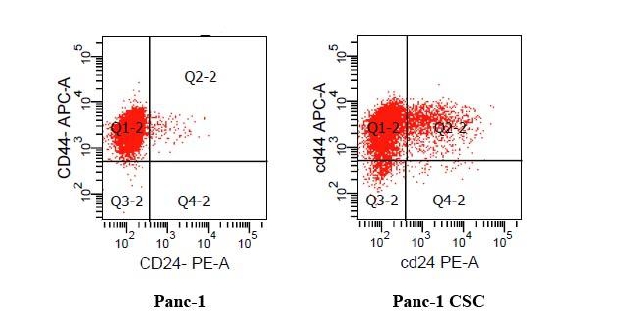
Figure 1 . The Panc-1 cell cancer stem cell (CSC) subpopulation (CD44+/CD24+) was enriched under sphere-forming conditions. The right upper quadrant (Q2-2) indicates the distribution of the CD44+/CD24+ subgroup of cells as analyzed by flow cytometry. The experiment was repeated 5 times and the data are expressed as mean ± standard deviation, statistically significant differences were determined by Student’s t test, the difference between the Panc-1 group and the Panc-1 CSC group was significant, p < 0.05.